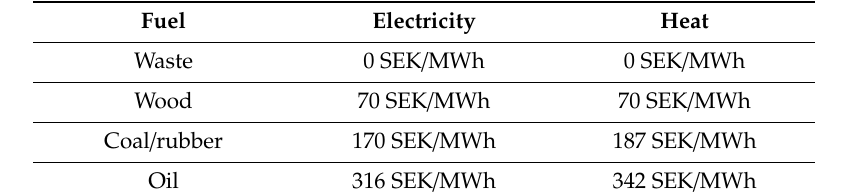
Table 9. Marginal fuel cost for power plant, real values from 2015, including taxes. Source: TvAB (the local energy company).